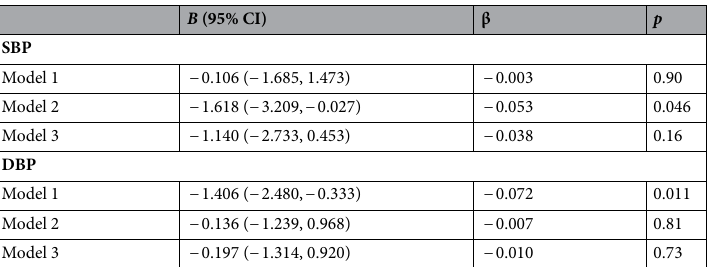
Table 3. Associations of serum folate levels with SBP and DBP. B : unstandardized coefficient; β: standardized coefficient; model 1: not adjusted; model 2: adjusted for age and sex; model 3: adjusted for age, sex, education level, household income, occupation, marital status, cigarette smoking, high-risk drinking, strength exercise, obesity, diabetes mellitus, family history of hypertension, energy intake, and sodium intake. Serum folate levels (ng/mL) were naturally log-transformed.